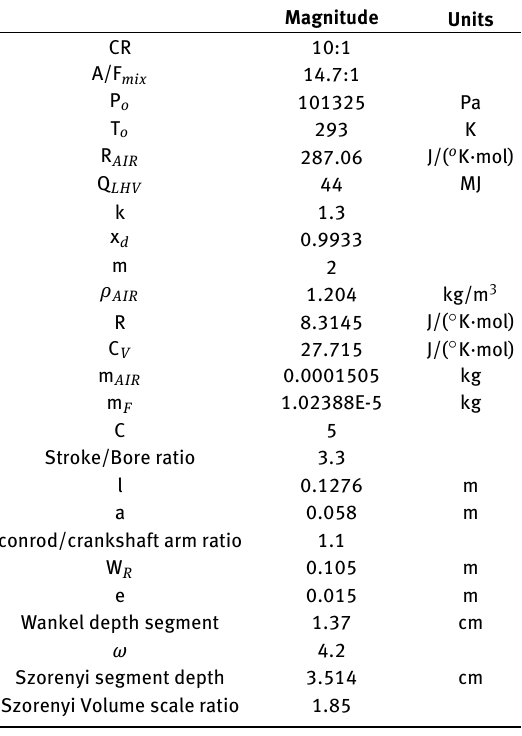
Table 1: Assumptions made for all engines